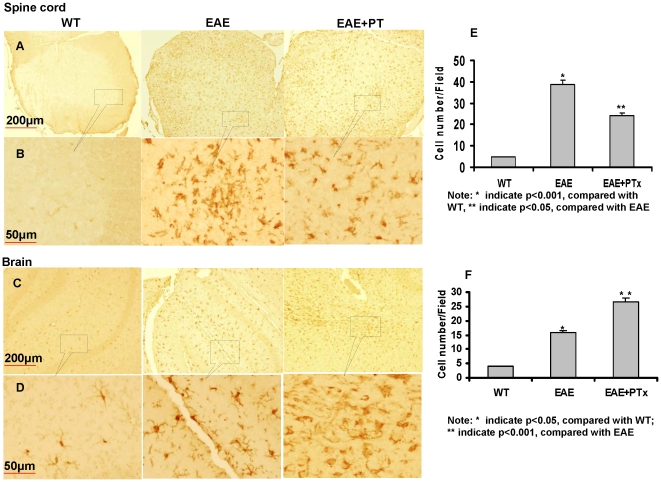
Anti-Iba1 immunostaining of spinal cord and brain of WT, EAE and EAE + PTx icv mice.Brain and spinal cord sections were immuno-stained at 7 days post MOG immunization with the anti-Iba1 antibody. A: Low-magnification image of spinal cord section (Scale bar = 200 µm). The anti-Iba1 antibody reacted strongly with amoeboid-shaped cells, corresponding to activated microglia in the spinal cord of EAE mice. This was significantly less prominent in the EAE+ PTx icv mice. In WT controls, the antibody also effectively, but rather weakly, recognized ramified or resting microglia; these cells have small bodies and finely branched processes. B: High-magnification image of the spinal cord sections (Scale bar = 50 µm). C: Low-magnification image of cerebral cortex (Scale bar = 200 µm). The anti-Iba1 antibody reacted strongly with amoeboid-shaped cells, corresponding to activated microglia in the brain of EAE+ PTx icv mice. WT controls manifest ramified or resting microglia; whereas EAE mice manifest an intermediate stage. D: High-magnification image of the brain sections (Scale bar = 50 µm). E-F. Microglia were quantified and compared among the groups by counting the number of cells in the field. Five random fields at 40X fields were counted for each condition under a digital axoplan microscope. Results were shown as the cells counted per 40X field. * p<0.05 compared with wt; * * p<0.01, Compared with EAE.